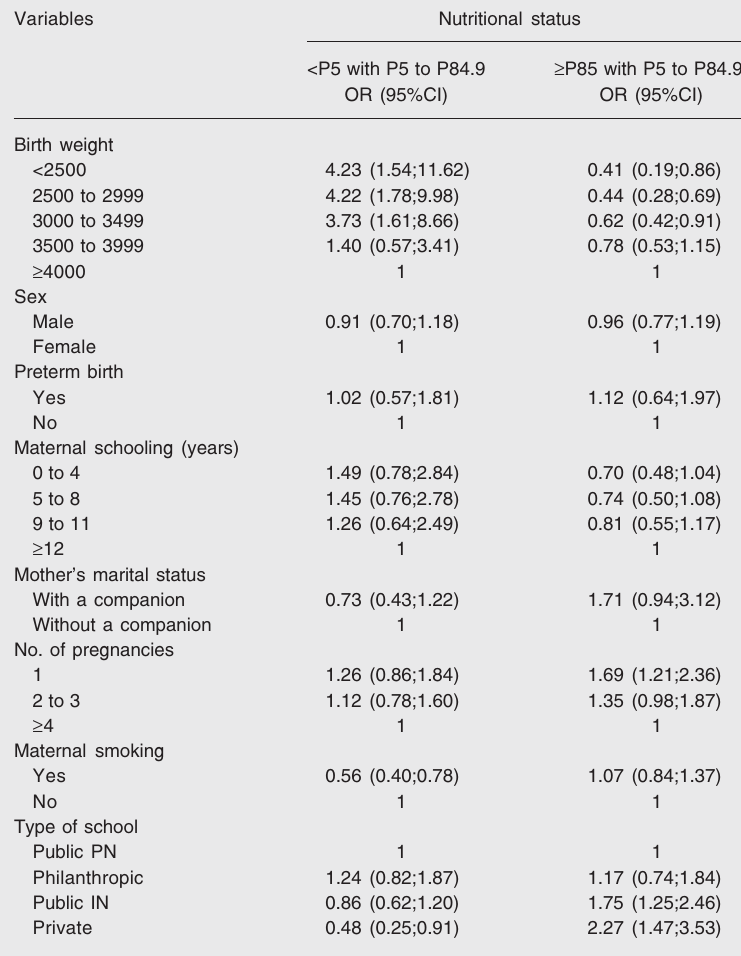
Table 4. Adjusted odds ratio for the comparison between the malnourished (<P5) and thin and normal (P5 to P84.9) classifications and between the excess weight ( ≥ P85) and thin and normal (P5 to P84.9)